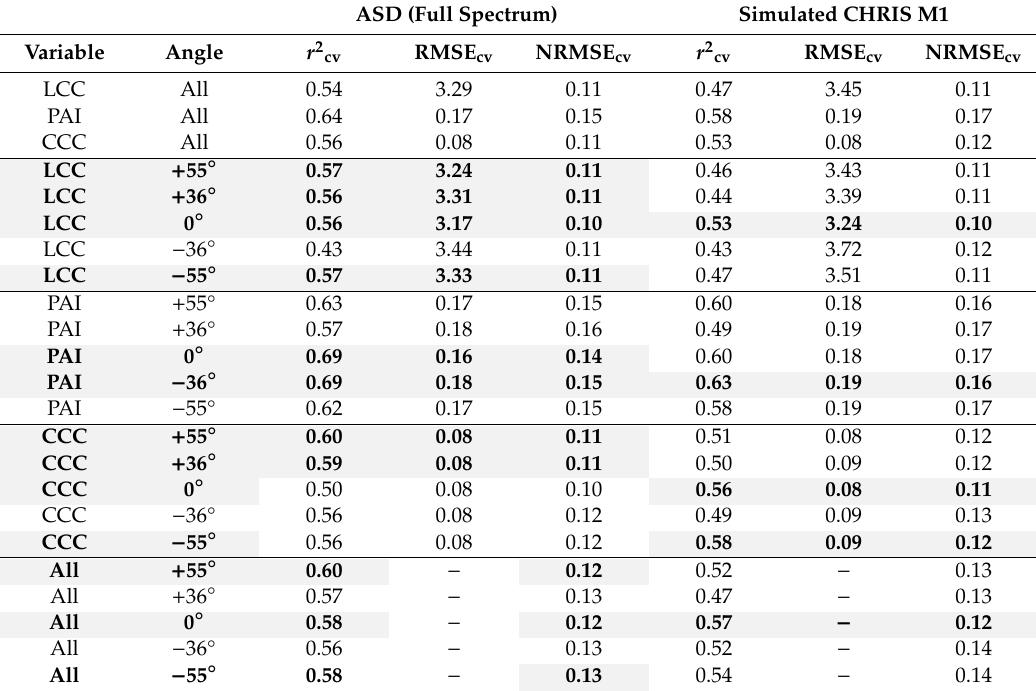
Table 4. SR model performance for plot scale data averaged over all sites and VZAs. RMSE cv